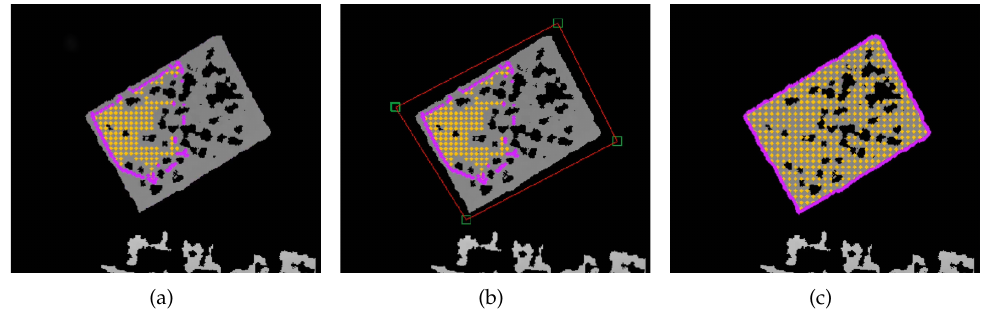
Figure 11. Dataset review and correction of depth sensors: ( a ) inaccurate labeling produced by automatic procedure; ( b ) definition of a polygon around the calibration pattern; ( c ) extraction of accurate labeling from the polygon.